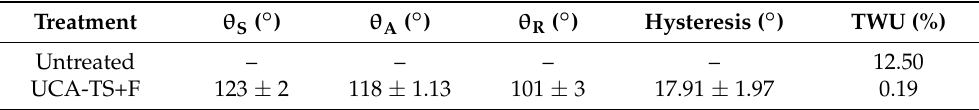
Table 4. Static CA values and their corresponding advancing and receding CA for the treated stones, and total water uptake by capillarity (TWU).